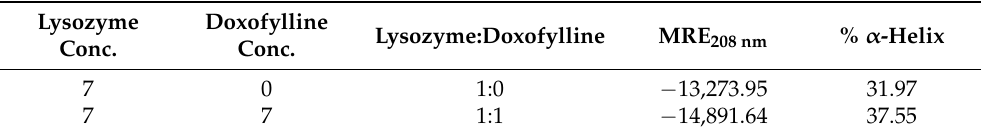
Figure 4. Far UV-CD spectra of lysozyme alone (7 µM) and lysozyme–doxofylline complex (7 µM each) at molar ratio of 1:1. Table 3. α -helical contents and MRE values of lysozyme in the absence and presence of doxofylline estimated from the CD data.